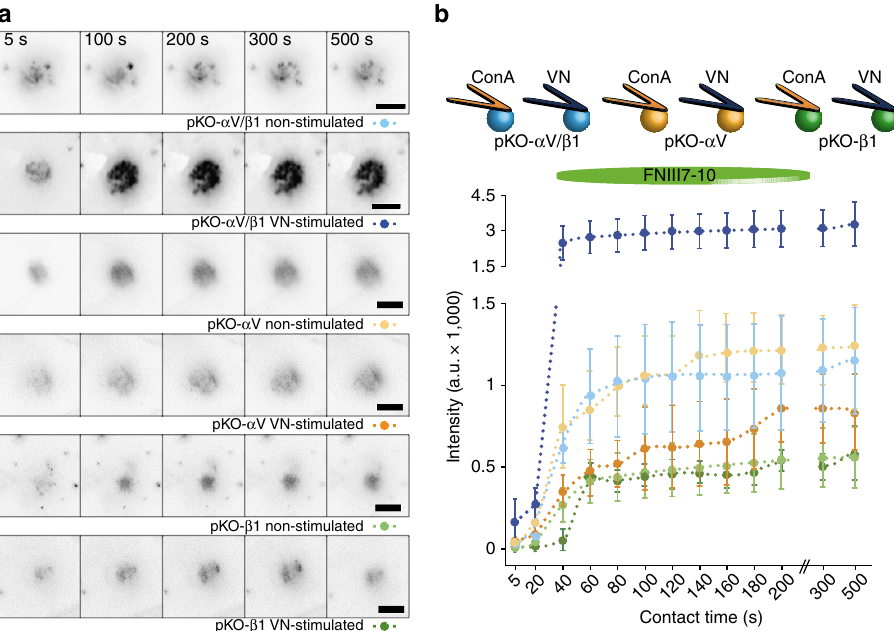
Figure 4 | Engagement of a V-class integrins induces a 5 b 1 integrin clustering. ( a ) Time series of TIRF images of GFP-labeled paxillin expressed in pKO- a V/ b 1 (blue), pKO- a V (yellow) and pKO- b 1 (green) fibroblasts adhering to FNIII7-10-coated substrates. To record the images, single fibroblasts were attached to ConA- (non-stimulated) or VN-coated (stimulated) cantilevers, incubated for 7-10min and then approached to the FNIII7-10-coated substrate. Paxillin–GFP–intensity was detected by TIRF microscopy after 5s and then after every 20s for up to 500s contact time with the substrate. To stimulate fibroblasts by VN, cantilevers were coated using 5 m gml –1 VN diluted in ConA. Scale bars, 10 m m. ( b ) Paxillin-GFP-intensity over contact time. The data were taken from TIRF images such as shown here and the statistical analysis of the data is given in Supplementary Table 1. Dots show mean fluorescence intensities of fibroblasts and error bars show s.e.m. ( n Z 10 for each